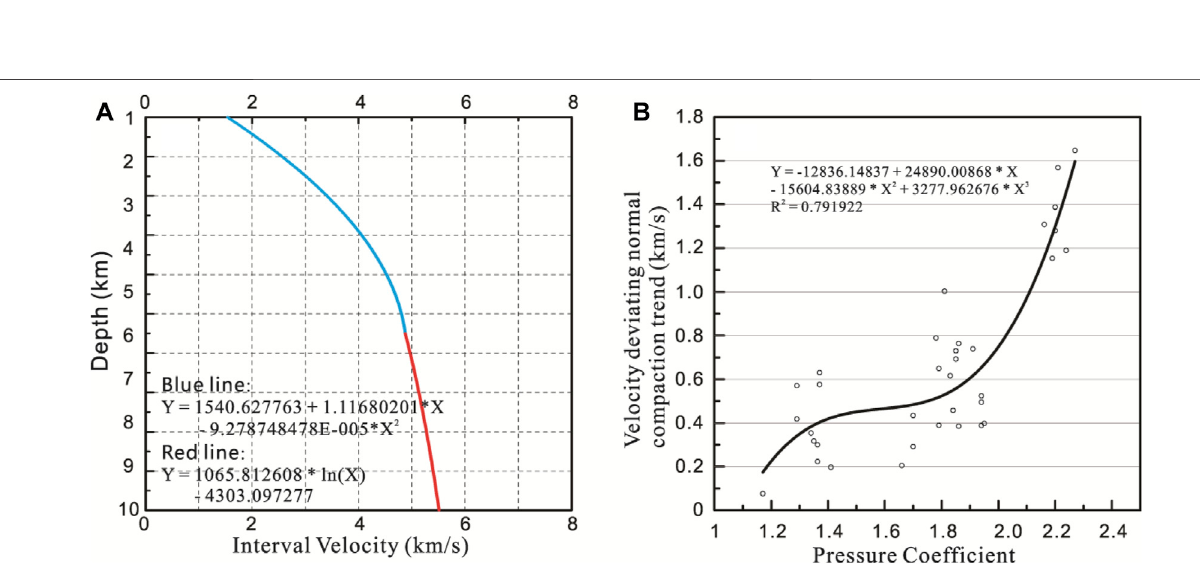
Frontiers in Earth Science |